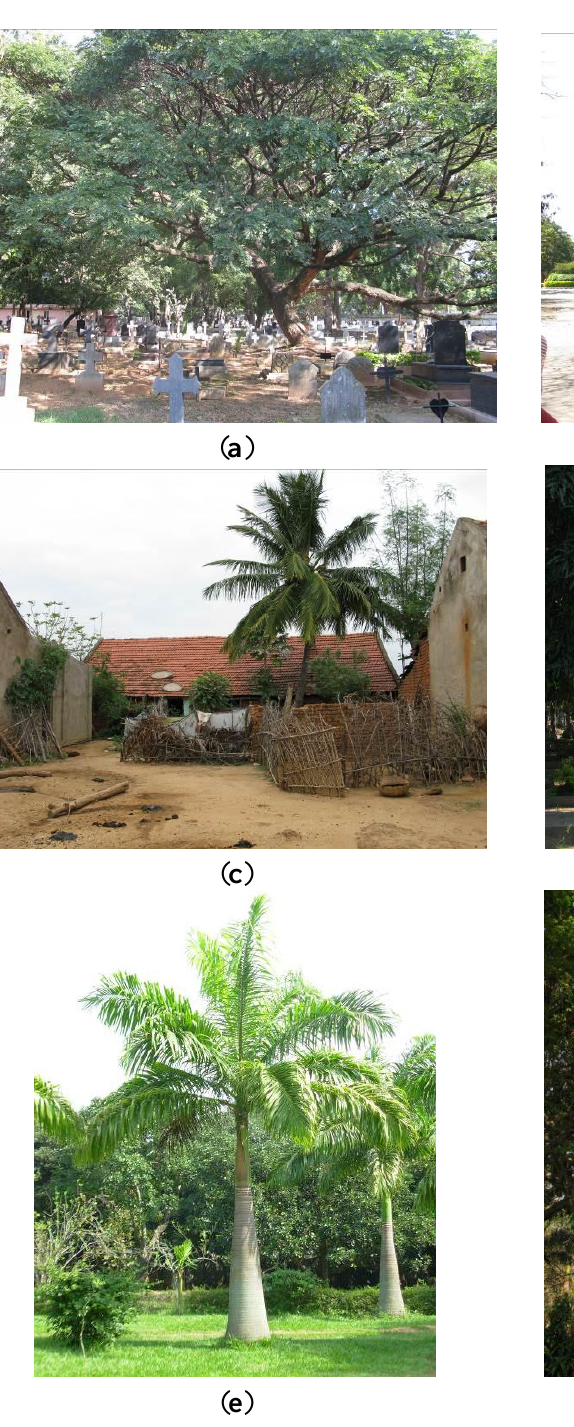
Figure 3. Profile photographs of six common tree species in Bangalore (photograph of royal palm by Divya Gopal; all other photographs by Harini Nagendra). ( a ) Samanea saman (rain tree); ( b ) Mangifera indica (mango); ( c ) Cocos nucifera (coconut); ( d ) Polyalthia